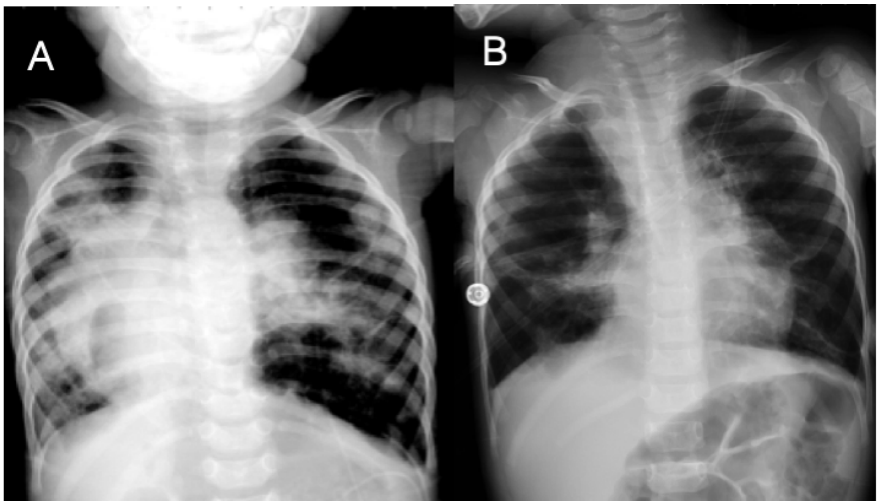
Figure 3. An extremely preterm male infant was diagnosed with bronchopulmonary dysplasia (BPD) and pulmonary hypertension. Chest radiography at the age of 3 years demonstrated dextrocardia, widespread coarse interstitial markings, atelectasis, and regions of hyperexpansion ( A ). A preterm female infant was diagnosed with BPD and pulmonary hypertension. Her chest radiography at the age of 2 years also showed the coarse interstitial markings, atelectasis, and regions of hyperexpansion ( B ) typical of BPD.